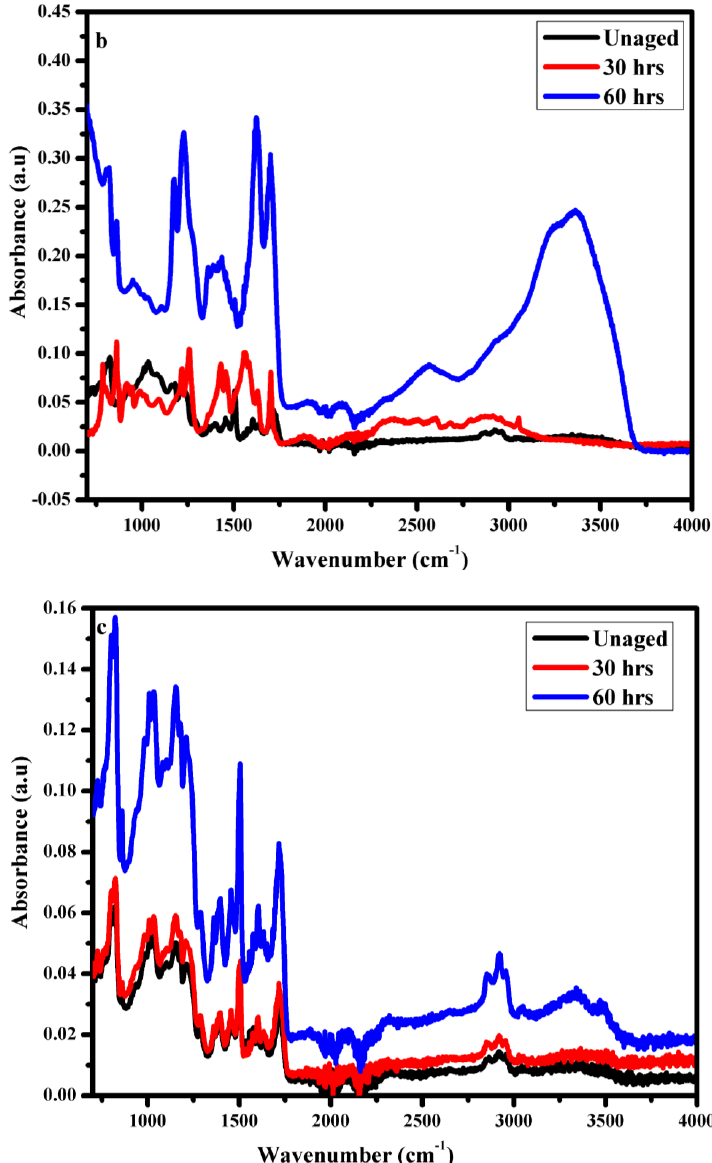
Figure 15. FTIR analysis of short-term aging ( a ) neat epoxy ( b ) epoxy microcomposite, and ( c ) epoxy nanocomposite.